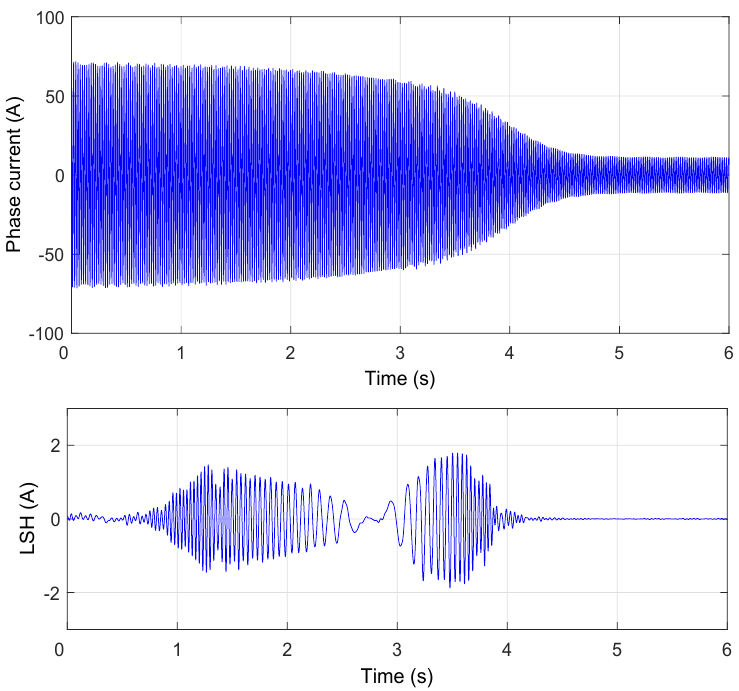
Figure 2. Simulated start-up current of an induction motor with one broken bar ( top ) and its corresponding LSHst ( bottom